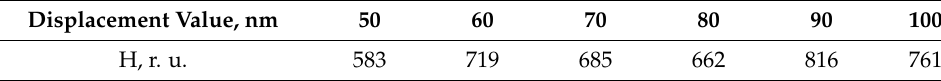
Table 1. Integral parameters of the excitation spectra of wheat seeds.